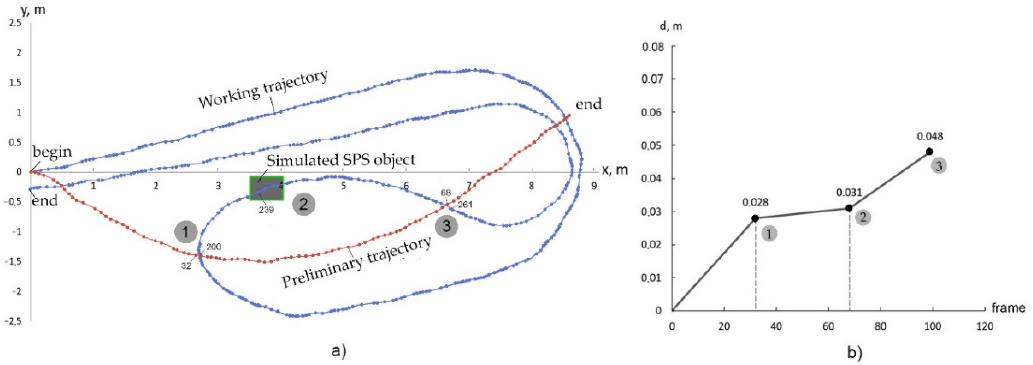
Figure 11. The real scene: ( a ) the preliminary run trajectory and the “working trajectory” with the specified points of referencing to the two 𝑃𝑅 (cid:2869) and to the object on the floor (in the XY plane); ( b ) the graph for error of preliminary trajectory (trajectory 1). Points 𝑃𝑅 (cid:2869)(cid:2869) and 𝑃𝑅 (cid:2870)(cid:2869) of VCRN are formed at positions 32 and 68, respectively.